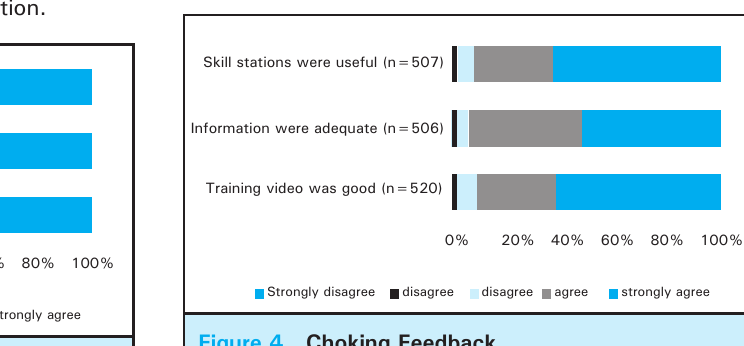
Figure 4. Choking Feedback.